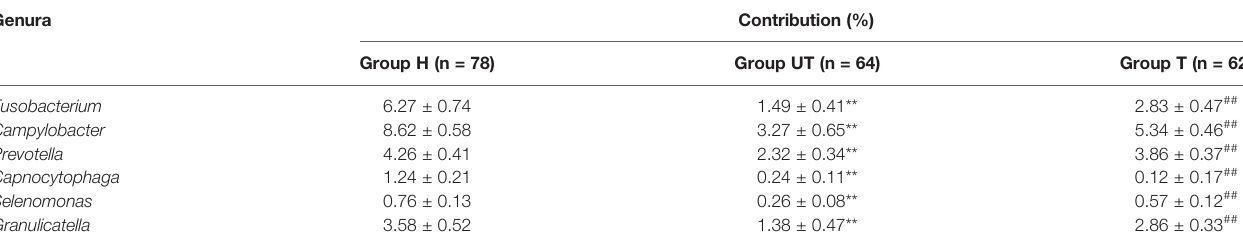
TABLE 6 | Different genera of bacteria in different saliva samples.